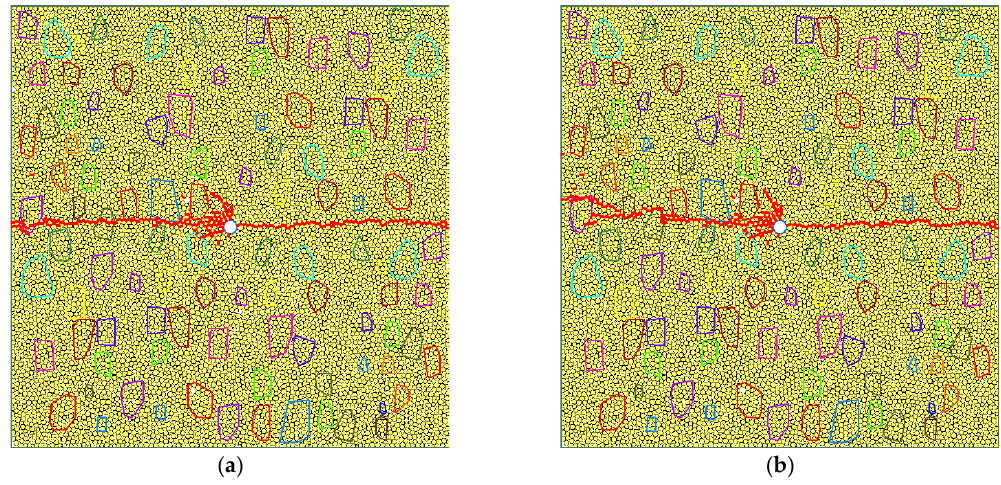
Figure 7. The fracture morphologies under different gravel strengths. ( a ) Gravel strength ratio is 1.6. ( b ) Gravel strength ratio is 1.8.